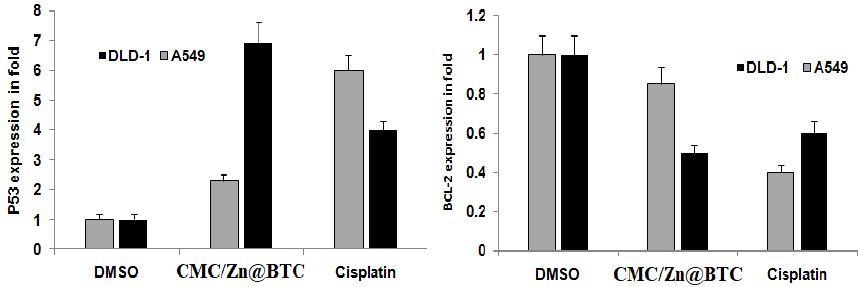
Figure 9. Effect of CMC/Zn@BTC on the expression of P53 and BCl-2 in cancer cell lines.